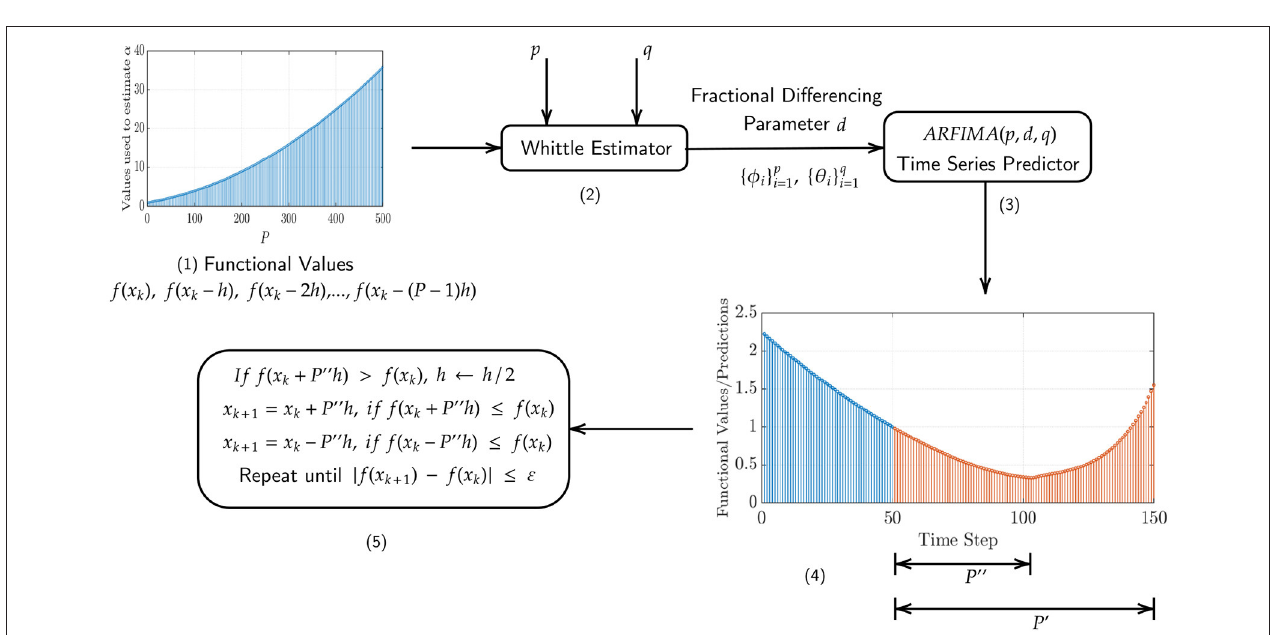
h ), ... , f ( x 0 ( P 1) h ), with pre-specified values of x 0 , P , and h , used − − − p q φ i i = 1 and { θ i } i = 1 , respectively. (3) The ARFIMA time series predictor, which predicts P ′ steps into the future. (4) { } P ′ , such that P ′′ satisfies y 1 y 2 y P y P ... . (5) Update step for the iterate x k ′′ ≤ ′′ + 1 ≤ ≥ ≥ ≥